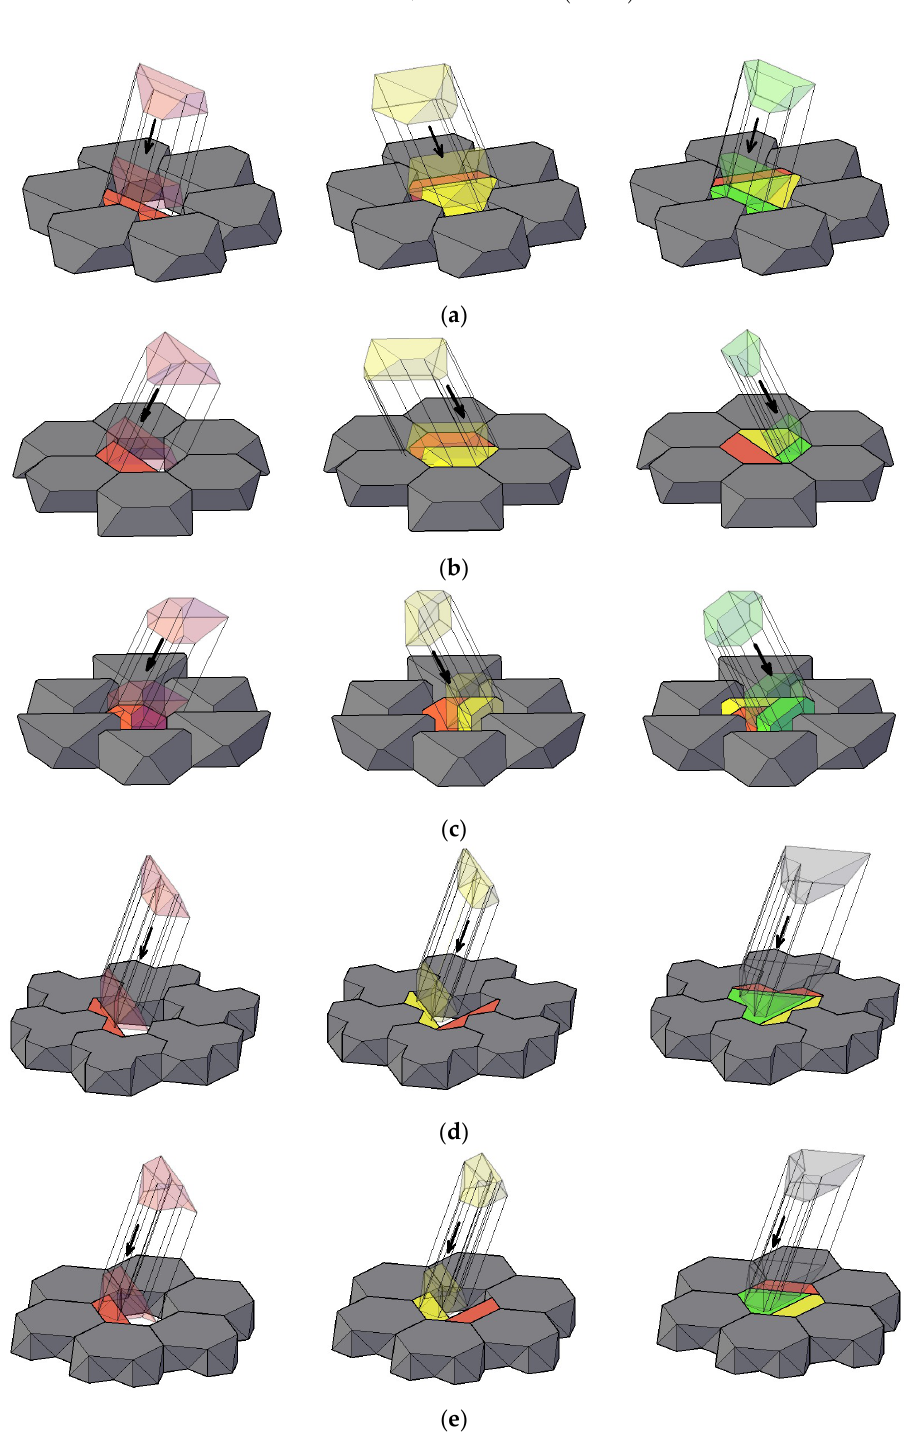
Figure 29. The order of entering parts of hexagonal keystones into the vault: ( a ) rough on both sides; ( b ) smooth from above; ( c ) smooth from below; and ( d , e ) both sides smooth.